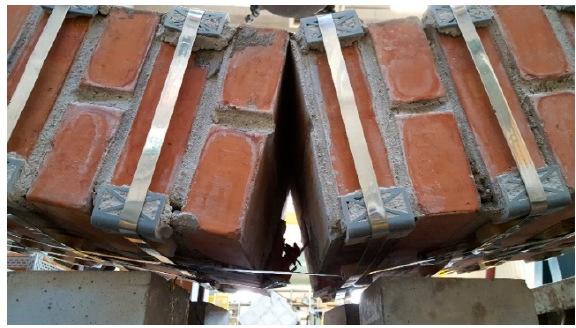
Figure 40. The internal hinge of Specimen W1, which has formed close to the loading piston.